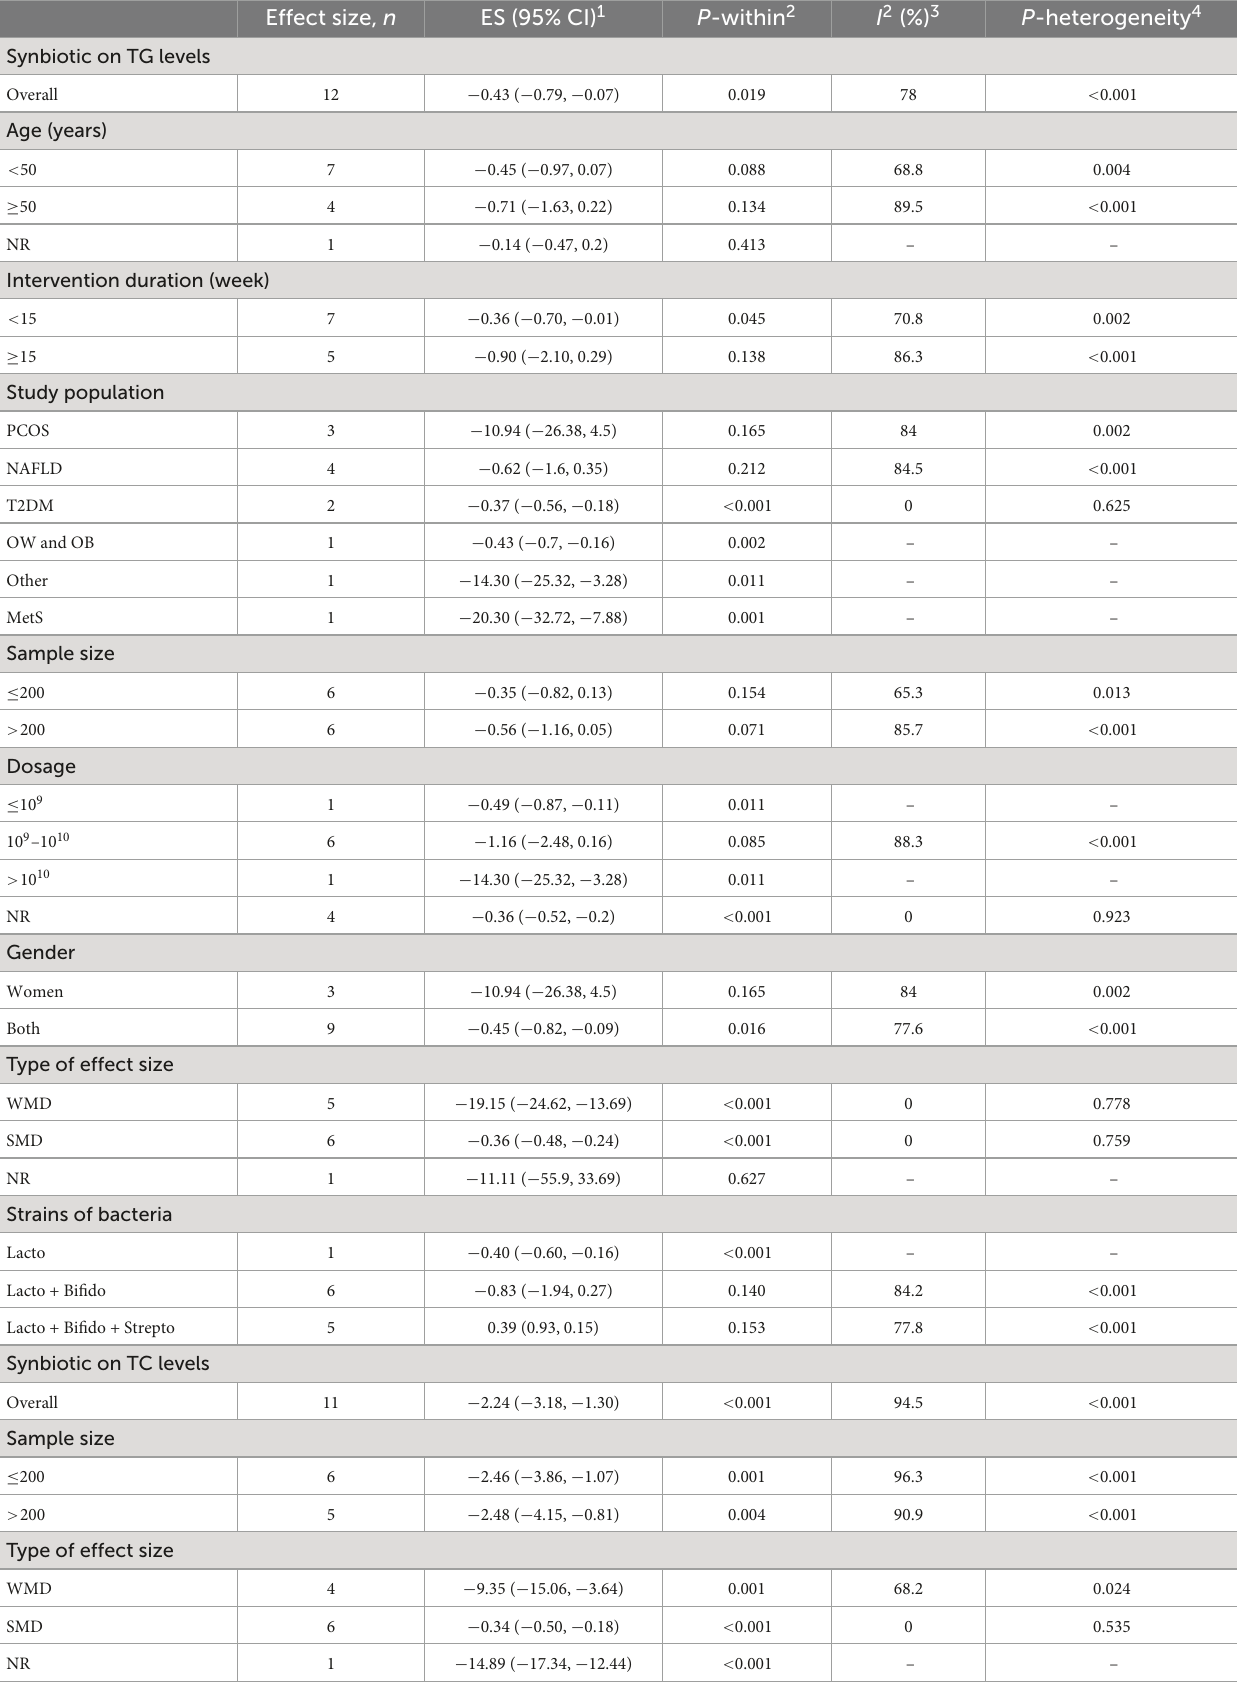
TABLE 5 Subgroup analyses for the effects of synbiotic supplementation on lipid profile. Effect size, n ES (95% CI) 1 P -within